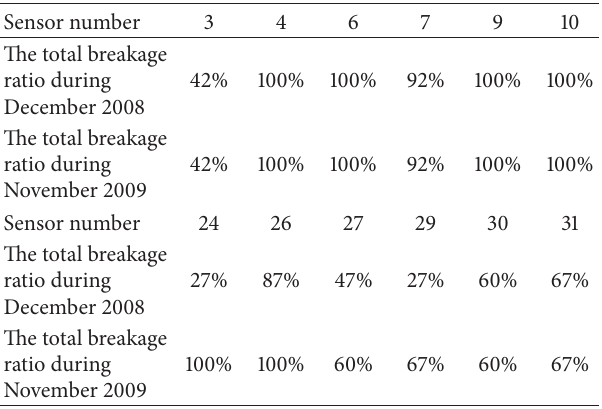
Table 1: Data of the smart films of tower no.